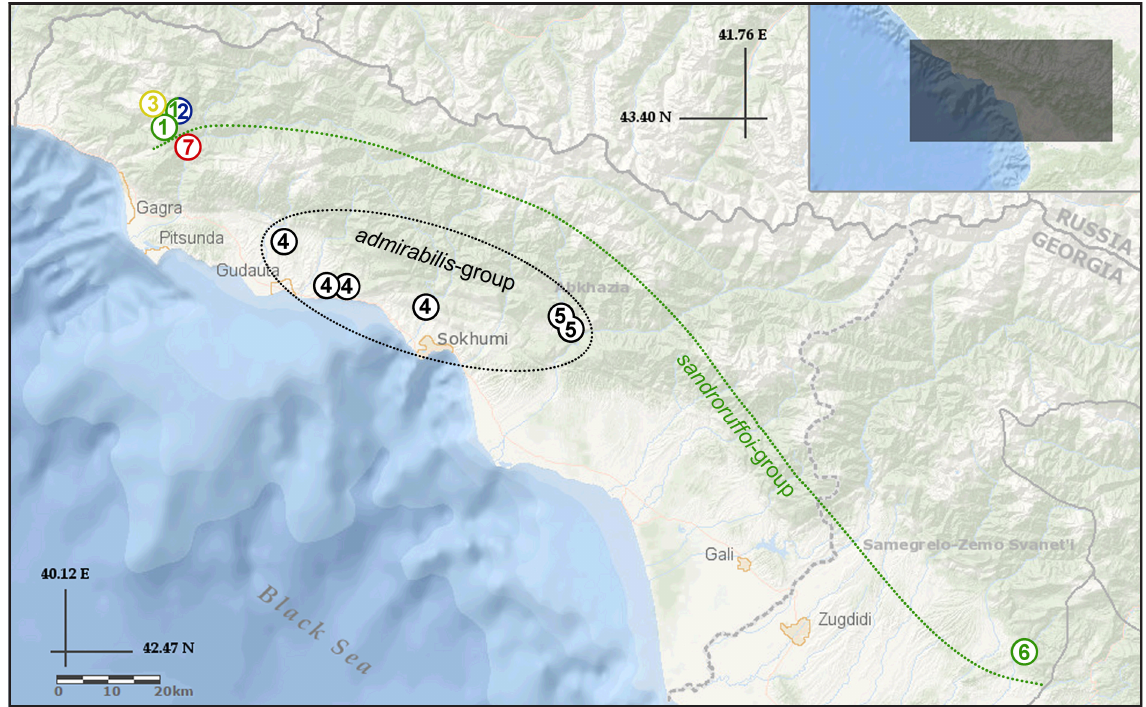
Fig. 1. Distribution map of Typhlogammaridae species and Anopogammarus in the Transcaucasia. 1 . Zenkevitchia sandroruffoi sp. nov. 2 . Adaugammarus pilosus gen. et sp. nov. 3 . Zenkevitchia sp. sensu Jaume in Sendra & Reboleira (2012). 4 . Zenkevitchia admirabilis (complex of species). 5 . Zenkevitchia yakovi Sidorov, 2015. 6 . Zenkevitchia revazi Birstein & Ljovuschkin, 1970, comb. resurr. 7 . Anopogammarus birsteini Derzhavin,